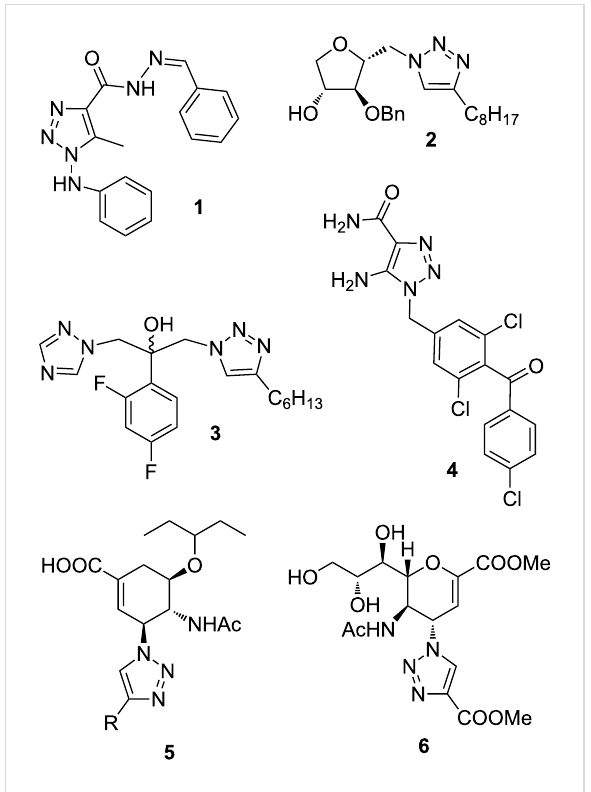
Probably the most useful and powerful procedure for the syn- thesis of 1,2,3-triazoles is the Huisgen 1,3-dipolar cycloaddi- tion of organic azides with acetylenes [16]. The classical Huisgen reaction, thermally induced, gives an approximate 1:1 mixture of 1,4- and 1,5-disubstituted 1,2,3-triazole isomers (Scheme 1) [17]. However, when Cu(I) catalysis is applied, the reaction becomes regioselective, exclusively yielding the 1,4- regioisomer within a relatively short reaction time [18-20].